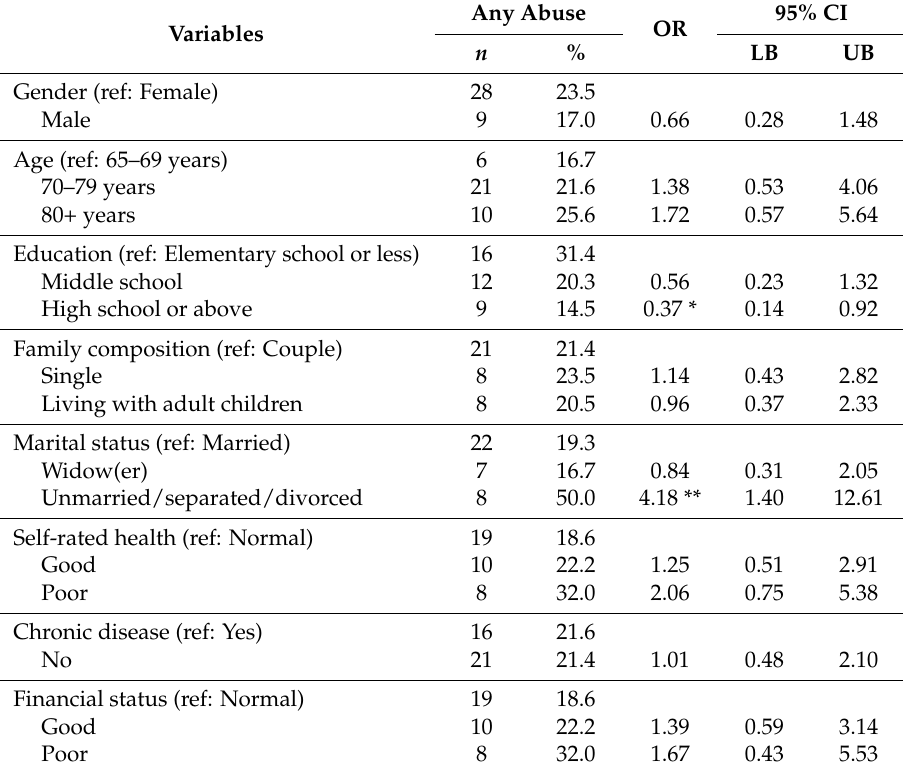
Table 3. Frequencies and Odds Ratios (ORs) from bivariate Logistic Regression models predicting any abuse.